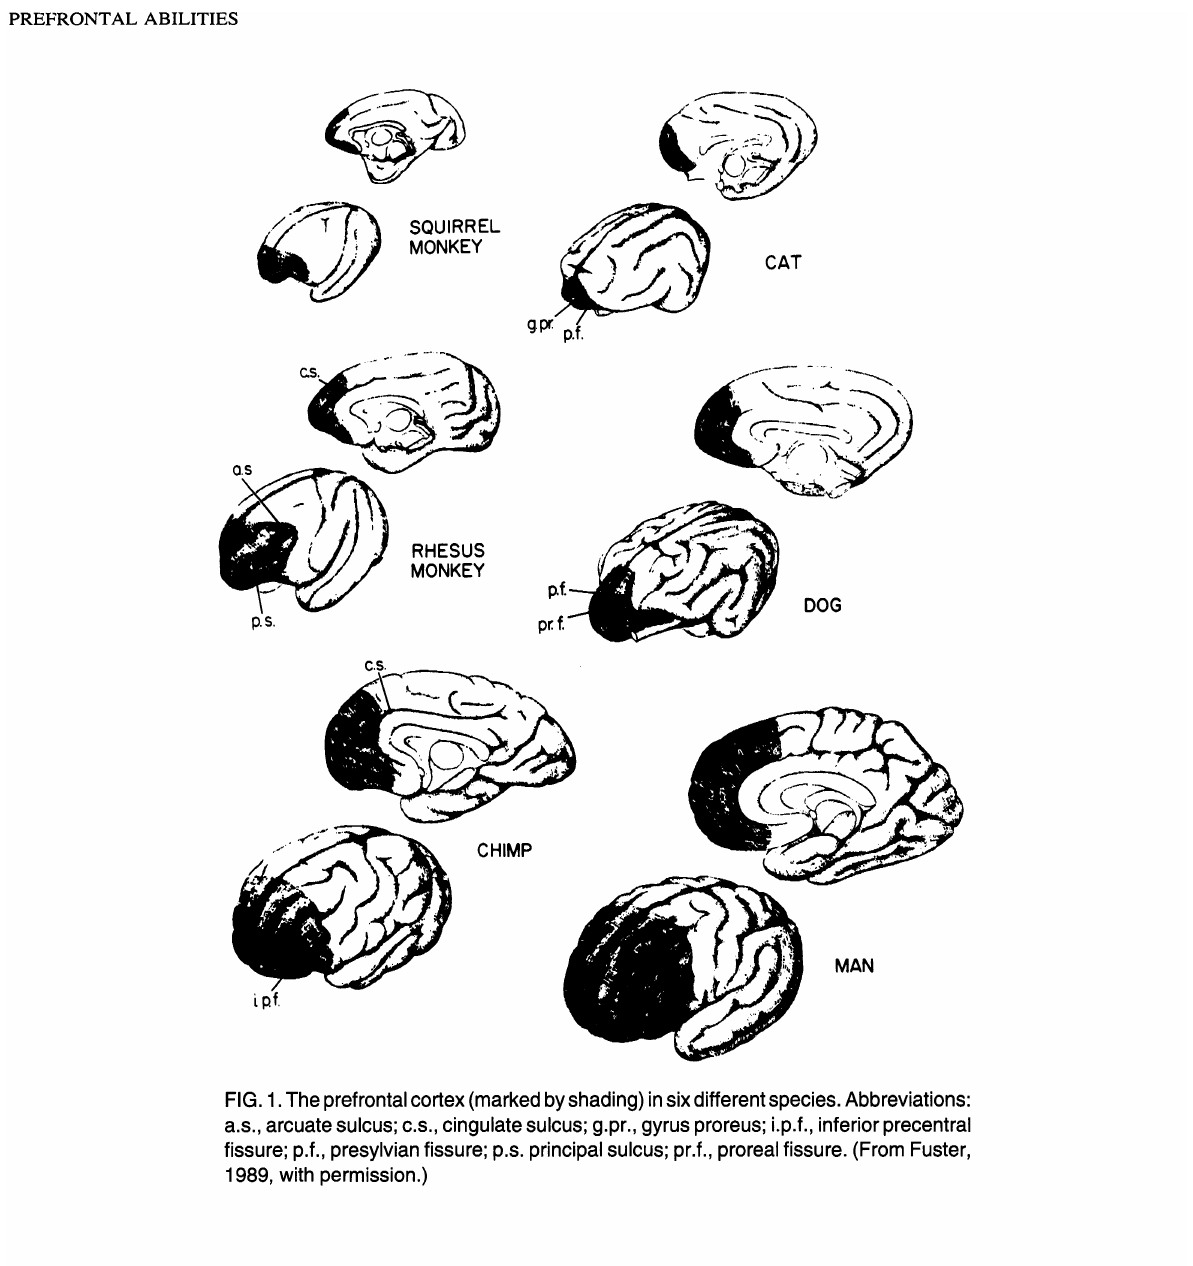
FIG. 1. The prefrontal cortex (marked by shading) in six different species. Abbreviations: a.s., arcuate sulcus; c.s., cingulate sulcus; g.pr., gyrus proreus; Lp.f., inferior precentral fissure; p.f., presylvian fissure; p.s. principal sulcus; pr.f., proreal fissure. (From Fuster, 1989, with